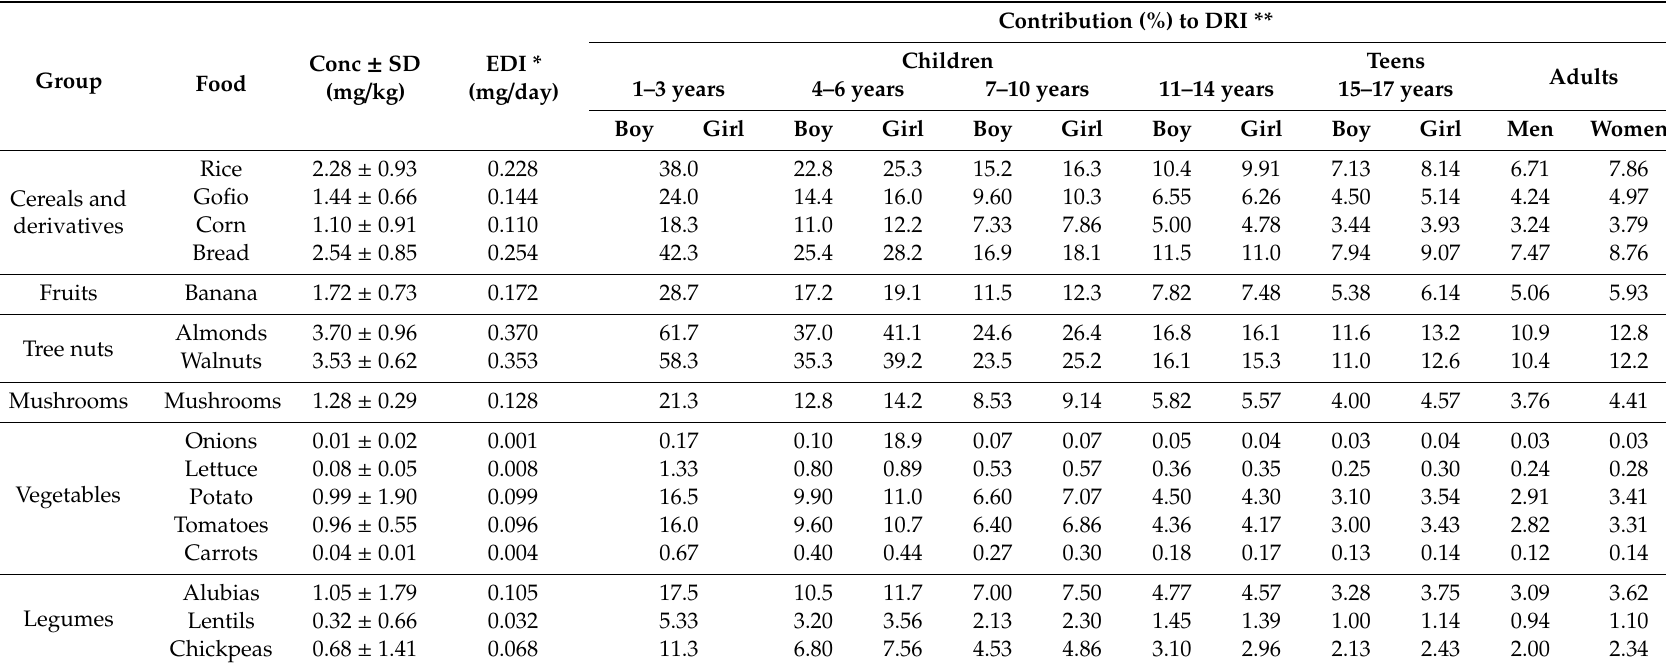
Table 3. Values of estimated daily intake (EDI) and contribution percentages (%) to the dietary recommended intake